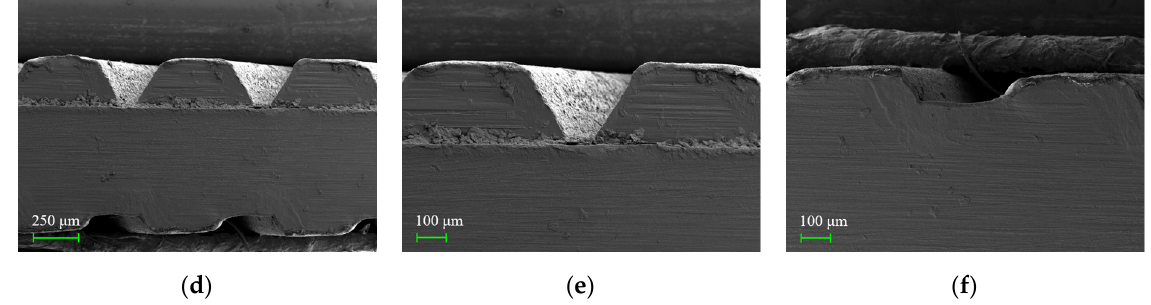
Figure 3. FESEM images showing the cross section of disc groove: ( a ) Semi-elliptic groove disc magnified at 150×; ( b ) Upper and ( c ) lower part of semi-elliptic groove disc at 250×; ( d ) Trapezoidal groove disc magnified at 150×; ( e ) Upper and ( f ) lower part of trapezoidal groove disc at 250×. Table 2. Cross-sectional dimensions of the disc groove.